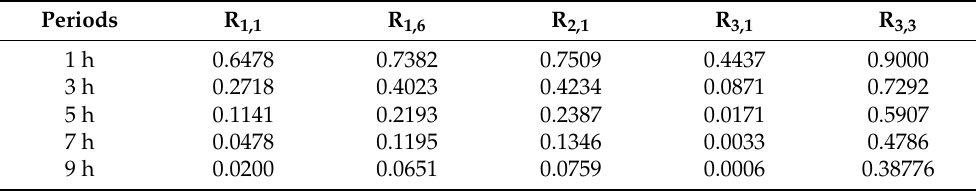
Table 10. Reliability for the component–subsystem relationships during five time periods from 17 to 28 May